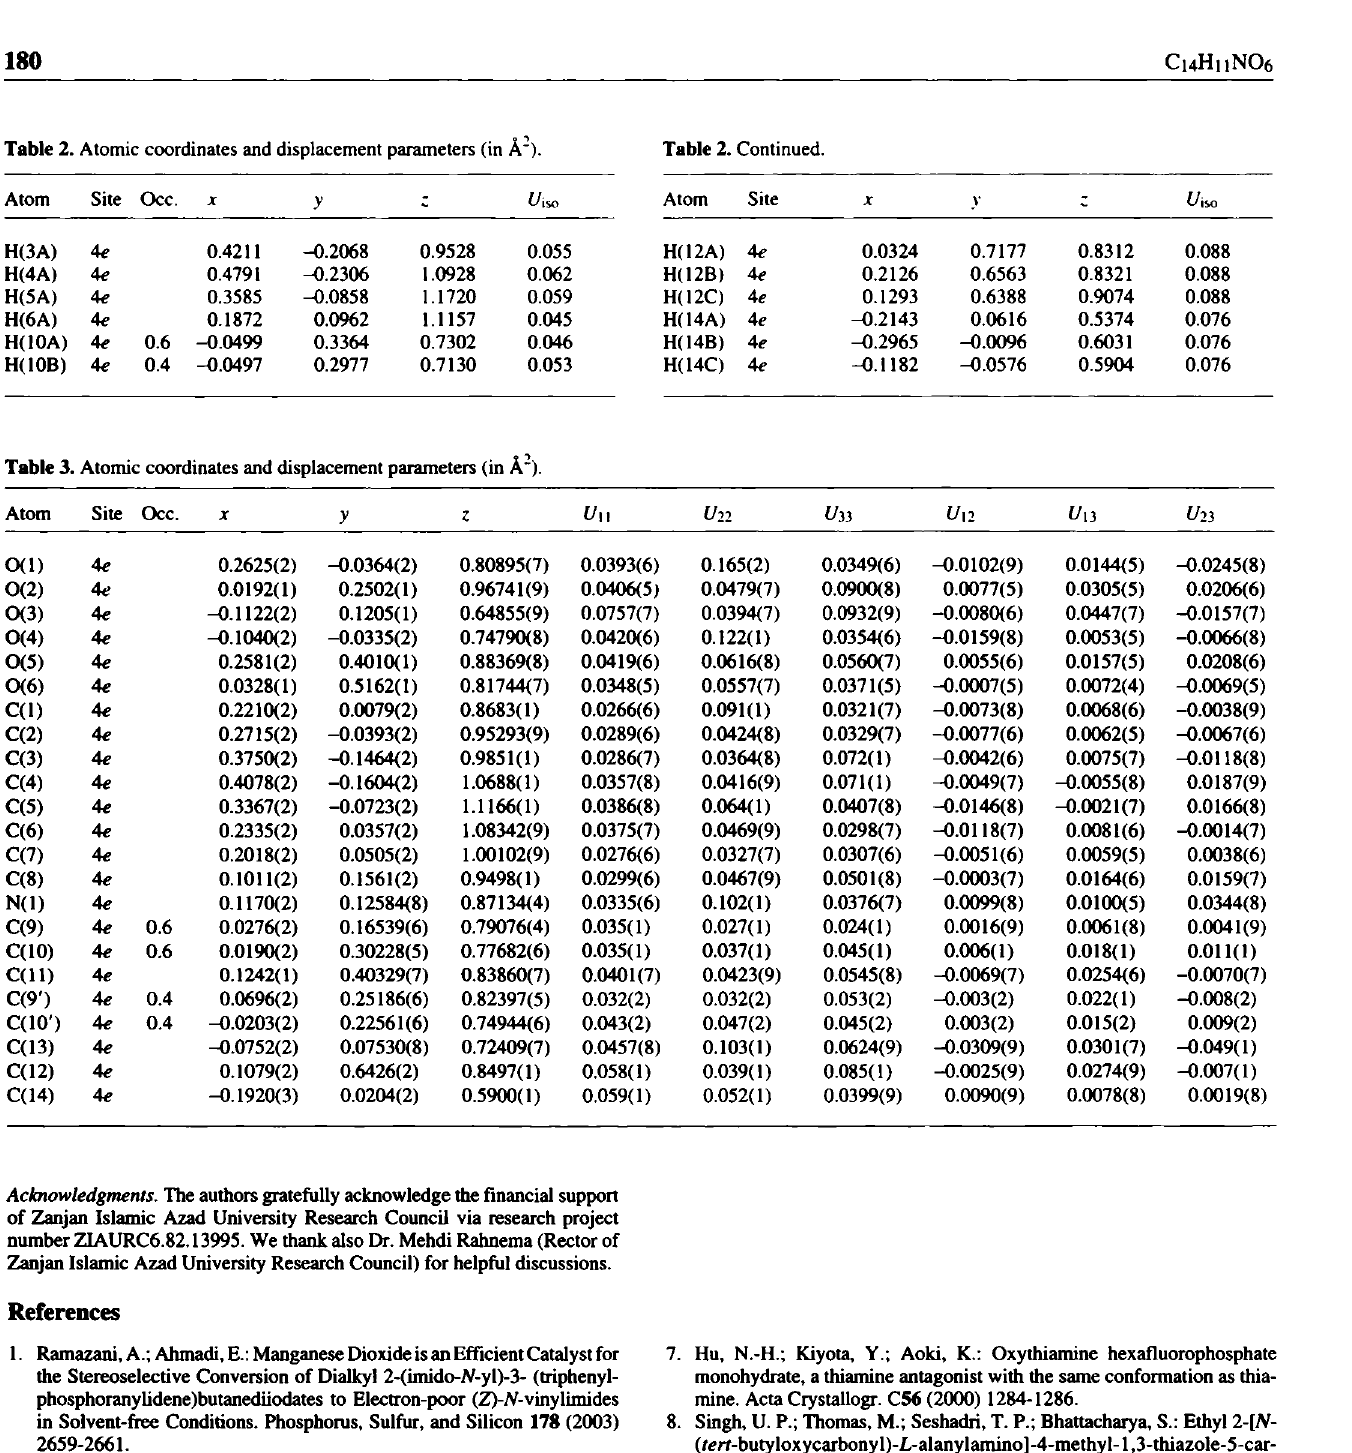
Table 2. Atomic coordinates and displacement parameters (in A : ). Table 2. Continued.